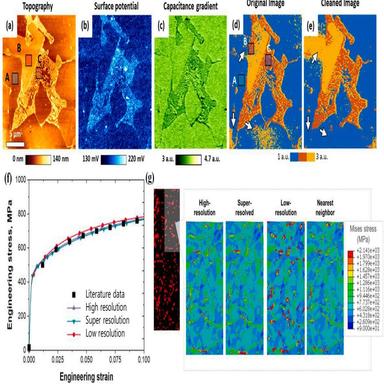
SPM images of as-prepared carbon steel: (a) topography, (b) surface potential, and (c) capacitance gradient. (d, e) Spatial maps of k-means clustering (d) before and (e) after de-noising process for (a-c) SPM images. (f) Stress-strain curves from experiment (square marks) and simulated microstructure data (marked curves) of CoCrFeMnNi high entropy alloy, and (g) simulated stress distribution after 5% tension for high-, super-, low-resolution and nearest neighbor. (a–e) Reproduced with permission from .](#pa